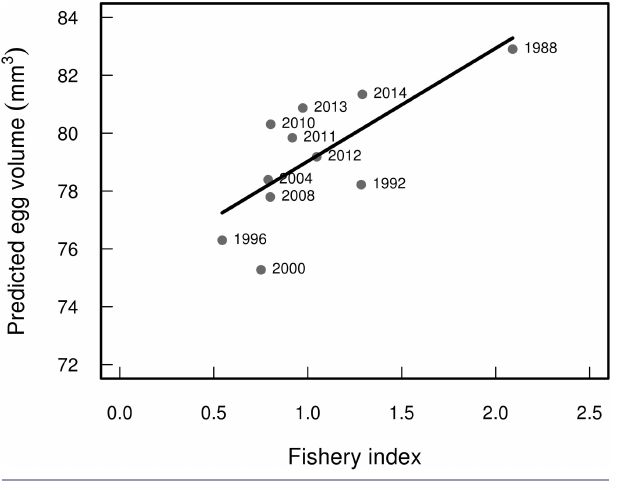
Fig. 3 . Herring Gull ( Larus argentatus ) egg volume predicted as a function of the fishery index from the top model (Table 1). Fishery index is a relative score of combined landings of lobster, herring, and groundfish (see methods for details and